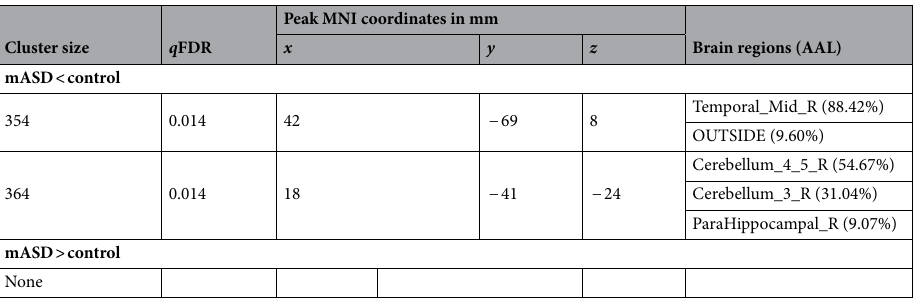
Table 2. Brain regions with significant volume differences between the mASD and control groups. Only clusters with q FDR < 0.05 and their maximum peak voxels are presented; only AAL-defined regions comprising ≥ 5% of a cluster are listed. The “OUTSIDE” anatomical label indicates a part of the region outside the parcellation. AAL automated anatomical labelling, MNI Montreal Neurological Institute, mASD mothers of individuals with autism spectrum disorder, qFDR false discovery rate q -value.